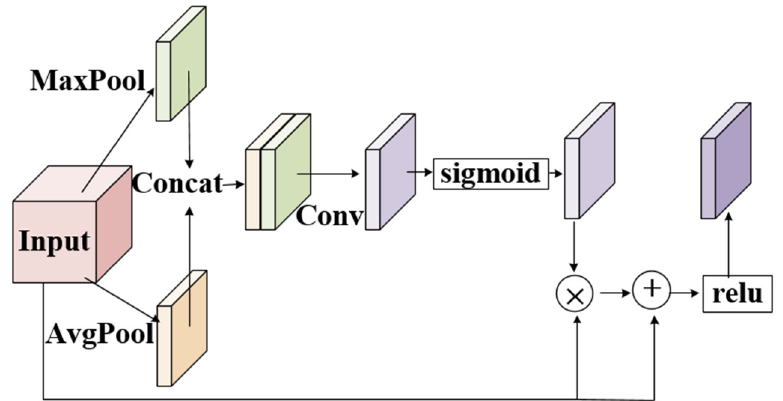
Figure 4. Schematic diagram of Residual Spatial Attention Module.